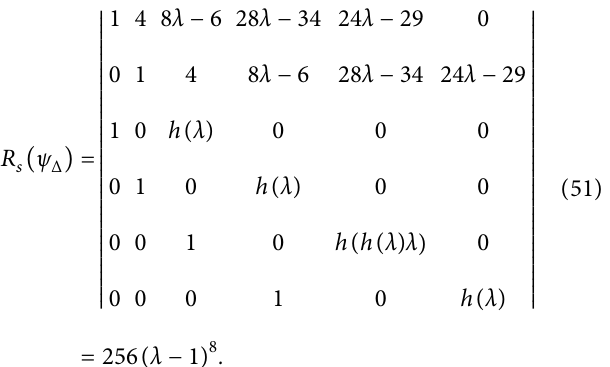
( λ ) on the interval [ 0 , 1 ] ; (b) figure of function φ A 1 ( λ ) on the interval [ 0 , 1 ] Δ